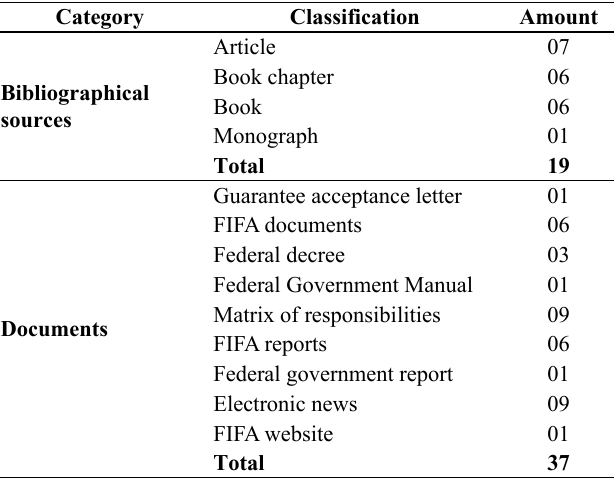
Table 1. Bibliographic sources and